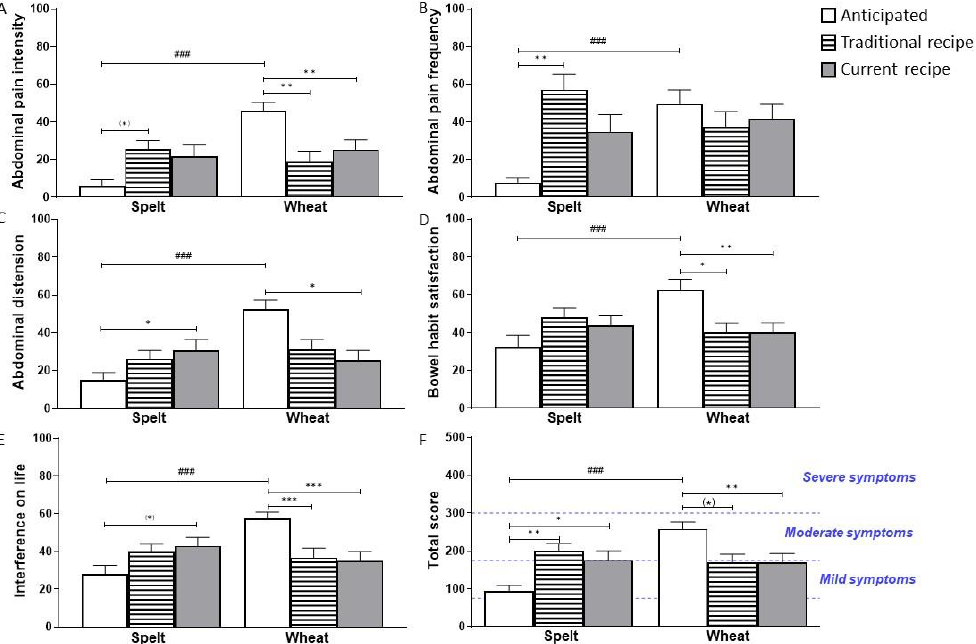
Figure 2. Results of Irritable Bowel Syndrome — Severity Scoring System (IBS-SSS) before (white) and after blinded consumption of traditional (patterned) and current (grey) wheat and spelt bread. The symptom scores for the 5 subscores ( A – E ) and IBS-SSS total score ( F ) as the sum of the 5 scores are shown. Statistics by t -test (only between anticipated scores of wheat and spelt) and Friedman/Dunn. ( * ) p < 0.1; * p < 0.05; ** p < 0.01; ### /*** p < 0.001.